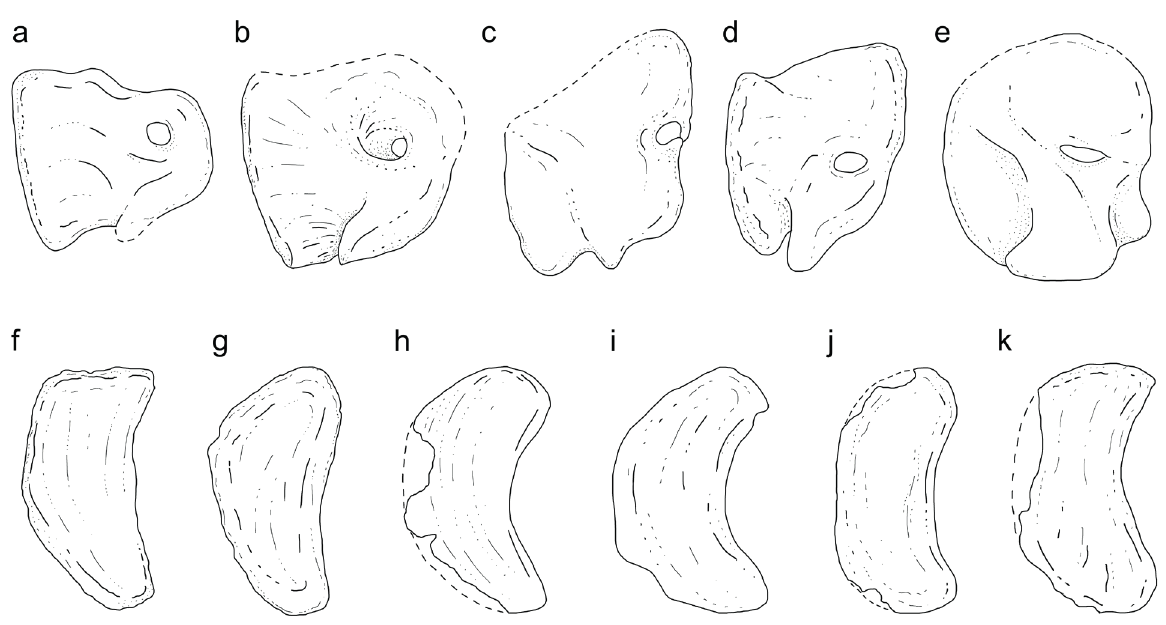
Figure 3 – Morphological comparison of titanosaurian coracoids ( a - e ) and sternal plates ( f - k ). South American (Argentinean) taxa denoted with an asterisk. ( a ) right coracoid in medial view of Neuquensaurus australis *, MLP-Ly 14, redrawn from Otero (2010), ( b ) left coracoid in lateral view of Saltasaurus loricatus *, PVL 4017-100, redrawn from Powell (1992), ( c ) right coracoid in medial view of Quetecsaurus rusconii *, UNCUYO-LD 300.15, redrawn from González riga and Ortiz David (2014), ( d ) left coracoid in lateral view of Opisthocoelicaudia skarzynskii , ZPAL MgD-I/48, redrawn from Borsuk-Bialynicka (1977), ( e ) left coracoid in lateral view of Dreadnoughtus schrani *, MPM-PV 1156, redrawn from Ullmann and Lacovara (2016), ( f ) right sternal plate in dorsal view of Mendozasaurus neguyelap *, IANIGLA-PV 067, redrawn from González riga et al. (2018), ( g ) right sternal plate in dorsal view of Choconsaurus baileywillisi *, MMCh-Pv 44/11, redrawn from Simón et al. (2018), ( h ) left sternal plate in ventral view of Saltasaurus loricatus *, PVL 4017-102, redrawn from Powell (1992), ( i ) left sternal plate in ventral view of Narambuenatitan palomoi *, MAU-Pv-N-425, redrawn from Filippi et al. (2011a), ( j ) left sternal plate in ventral view of Dreadnoughtus schrani *, MPM-PV 1156, redrawn from Ullmann and Lacovara (2016), ( k ) left sternal plate in ventral view of Petrobrasaurus puestohernandezi *, MAU-Pv-N-449/25, redrawn from Filippi et al. (2011b). Not to